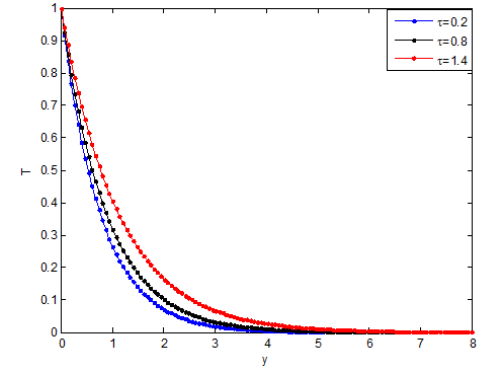
Figure 23. Effects of flow on the temperature distribution